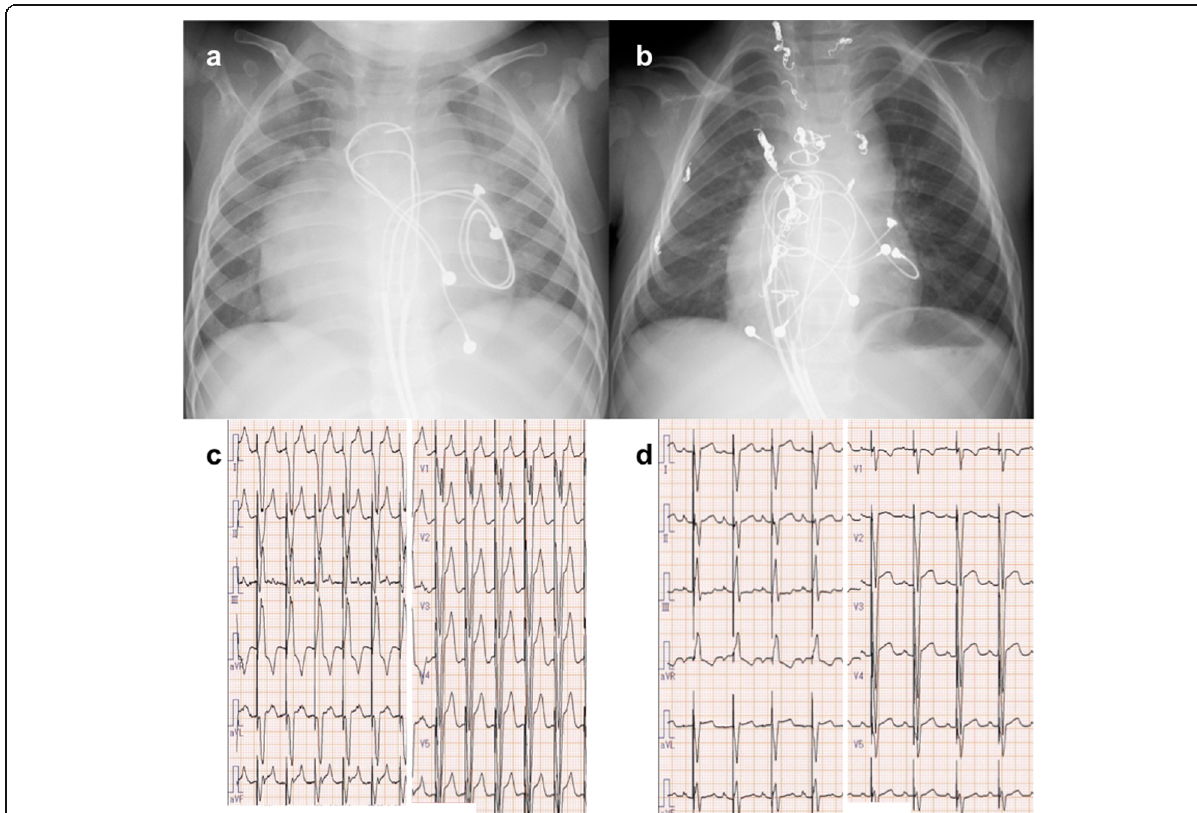
Fig. 3 a Chest radiograph before cardiac resynchronization therapy (CRT). The cardiothoracic ratio is 65%. Atrial leads are placed on the LA and ventricular leads on the mRV. b Chest radiograph post-CRT. The cardiothoracic ratio is reduced to 50%. New ventricular leads are placed on the mLV, and the cathode of the previous mRV pacing lead is re-located to the mRV outflow tract. c Electrocardiogram before CRT. QRS duration is 156 ms. d Electrocardiogram after CRT. QRS duration is shortened to 140 ms. CRT, cardiac resynchronization therapy; LA, left atrium; mRV, morphological right ventricle; mLV, morphological left